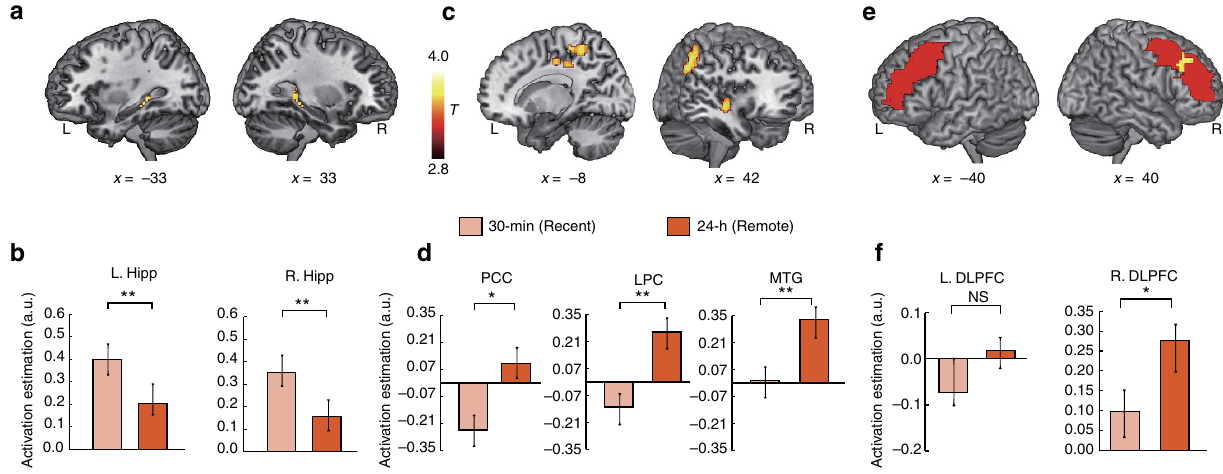
Figure 2 | Hippocampal–neocortical functional reorganization after consolidation. ( a ) Left (MNI, peak at (cid:2) 33, (cid:2) 33 and (cid:2) 6) and right hippocampus (MNI, peak at 33, (cid:2) 39 and (cid:2) 6) are involved in retrieval of newly acquired aversive memories in contrast to the overnight consolidation condition (T_30min 4 T_24h), including the left and right posterior hippocampus. ( b ) Bar graphs represent functional activation in the left and right hippocampus showing higher engagement during retrieval of newly acquired relative to consolidated memories. ( c ) Brain regions involved in retrieval of consolidated relative to newly acquired aversive memories (T_30min o T_24h), including the right lateral parietal cortex (LPC) and angular gyrus extending into the posterior cingulate cortex (PCC), and the right middle temporal gyrus (MTG). ( d ) Bar graphs represent functional activation in these cortical regions, with higher engagement during retrieval of consolidated relative to newly acquired memories. ( e , f ) Bar graphs represent changes in functional engagement of the right and left anatomically defined middle frontal gyrus (that is, DLPFC) during NoThink trials between newly acquired and consolidated memories (NT_30min o NT_24h). The significant functional cluster (in ‘hot’) in the right DLPFC showing the same effect between Time and Suppression was overlaid on the anatomically defined DLPFC (in ‘red’). Each bar graph was plotted against the fixation period in the TNTtask. Colour bars represent T values. DLPFC, dorsolateral prefrontal cortex; Hipp, hippocampus; L, left; MFG, middle frontal gyrus; R, right. Error bars represent s.e.m. * P o 0.05; ** P o 0.01; MNI, Montreal Neurological Institute coordinate